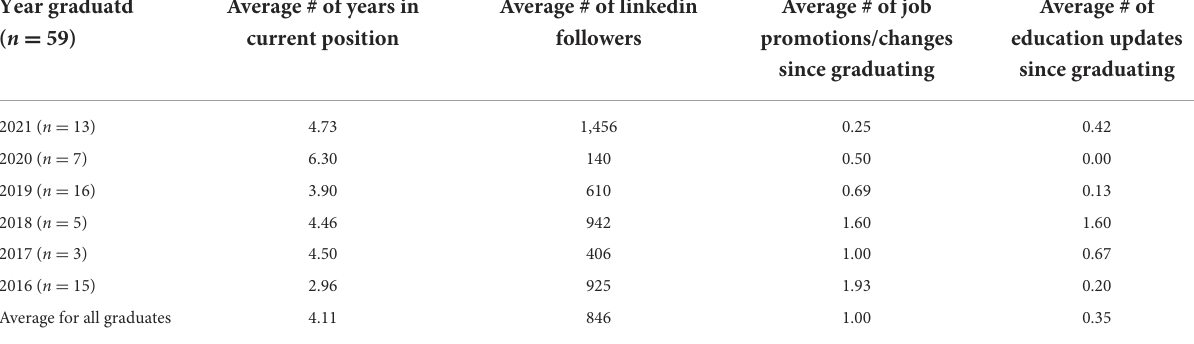
TABLE 4 Average career advances for graduates per